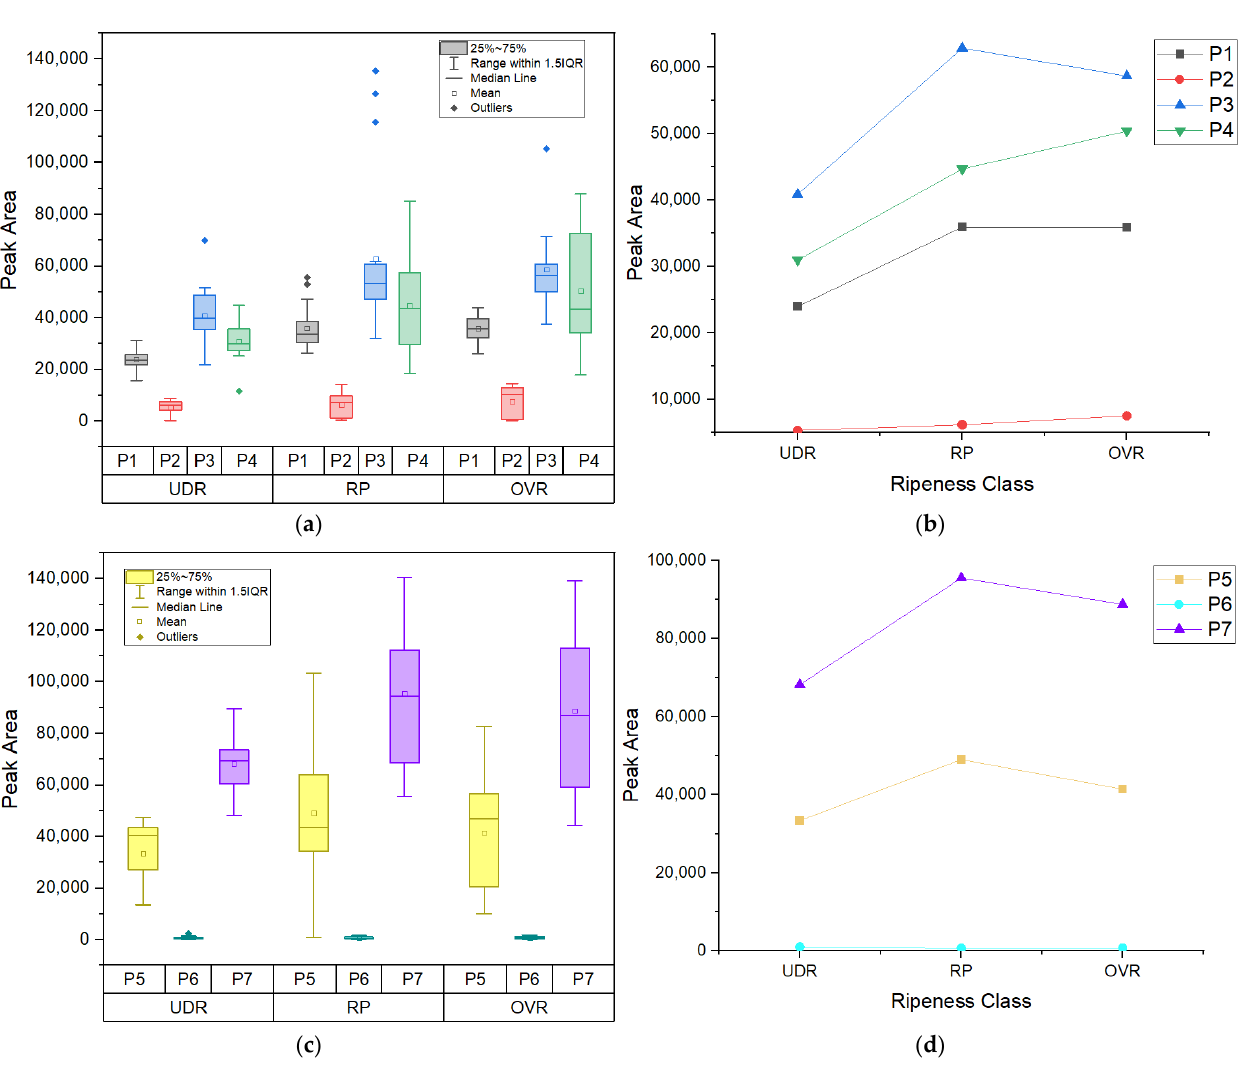
Figure 8. ( a ) Grouped box plot and ( b ) mean plot of peak’s area of 4 peaks in Area 1; ( c ) Grouped box plot and ( d ) mean plot of peak’s area of 3 peaks in Area 2. UDR: Under ripe, RP: Ripe, OVR: Over ripe; P1: β-carotene, P2: chlorophyll-a, P3: β-carotene, P4: amino acid, P5: β-carotene, P6: cuticular wax, P7: lycopene/β-carotene.